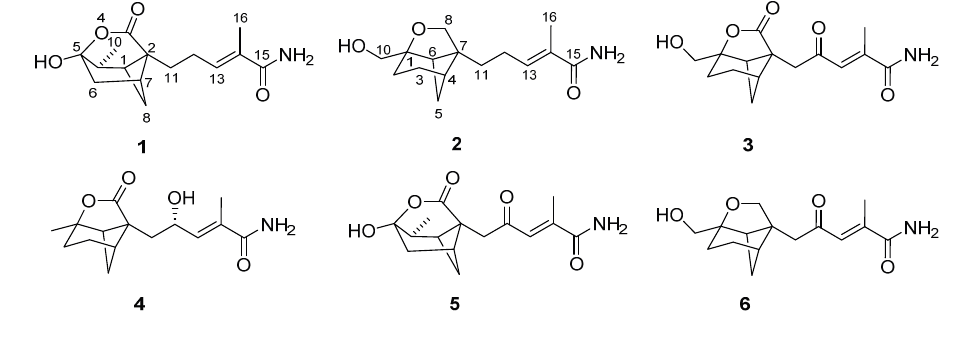
Figure 1. Structures of compounds 1 – 6